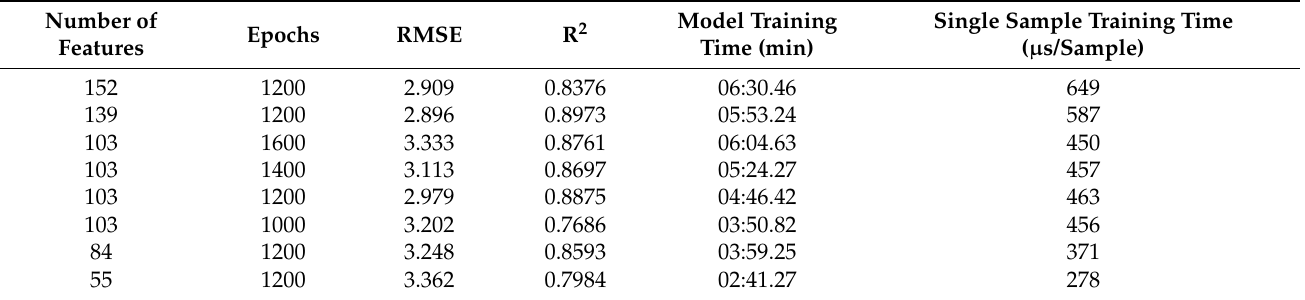
Table 2. Comparison of the inversion effects of different parameters of soil organic matter content in the